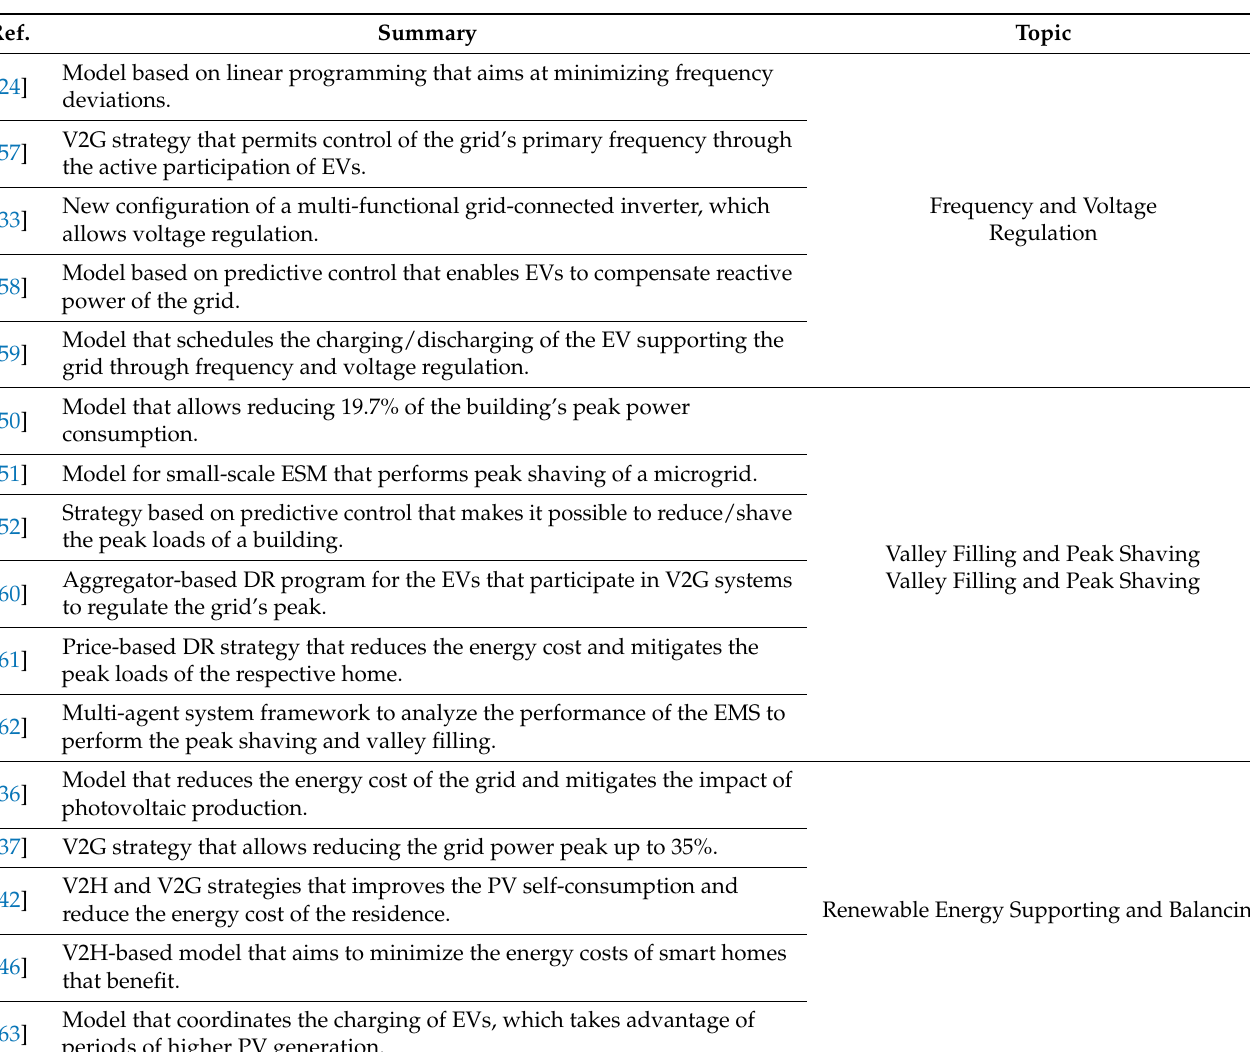
Table 5. Summary of ancillary services